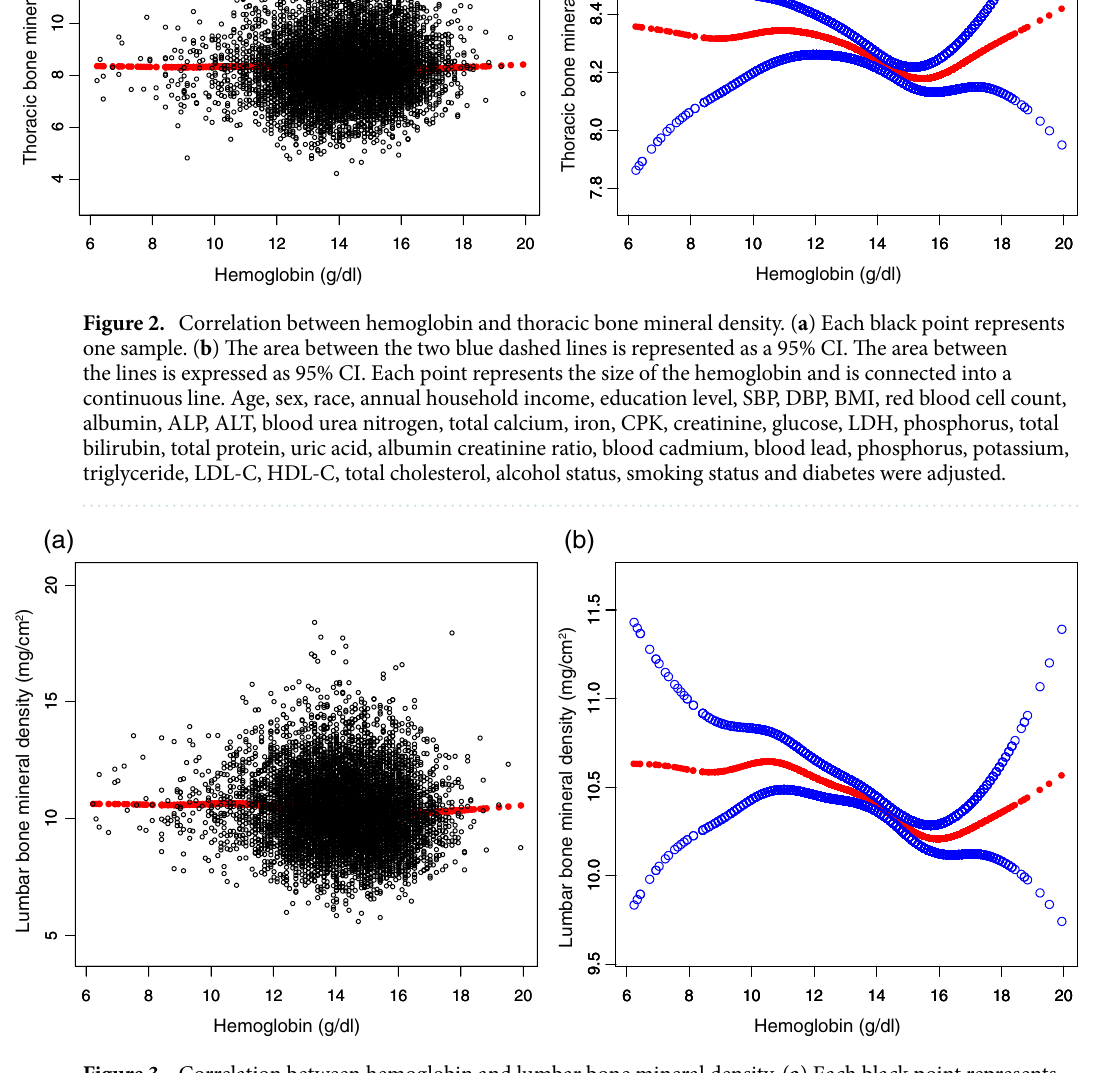
Figure 3. Correlation between hemoglobin and lumbar bone mineral density. ( a ) Each black point represents one sample. ( b ) The area between the two blue dashed lines is represented as a 95% CI. The area between the lines is expressed as 95% CI. Each point represents the size of the hemoglobin and is connected into a continuous line. Age,sex, race, annual household income, education level, SBP, DBP, BMI, red blood cell count, albumin, ALP, ALT, blood urea nitrogen, total calcium, iron, CPK, creatinine, glucose, LDH, phosphorus, total bilirubin, total protein, uric acid, albumin creatinine ratio, blood cadmium, blood lead, phosphorus, potassium, triglyceride, LDL-C, HDL-C, total cholesterol, alcohol status, smoking status and diabetes were